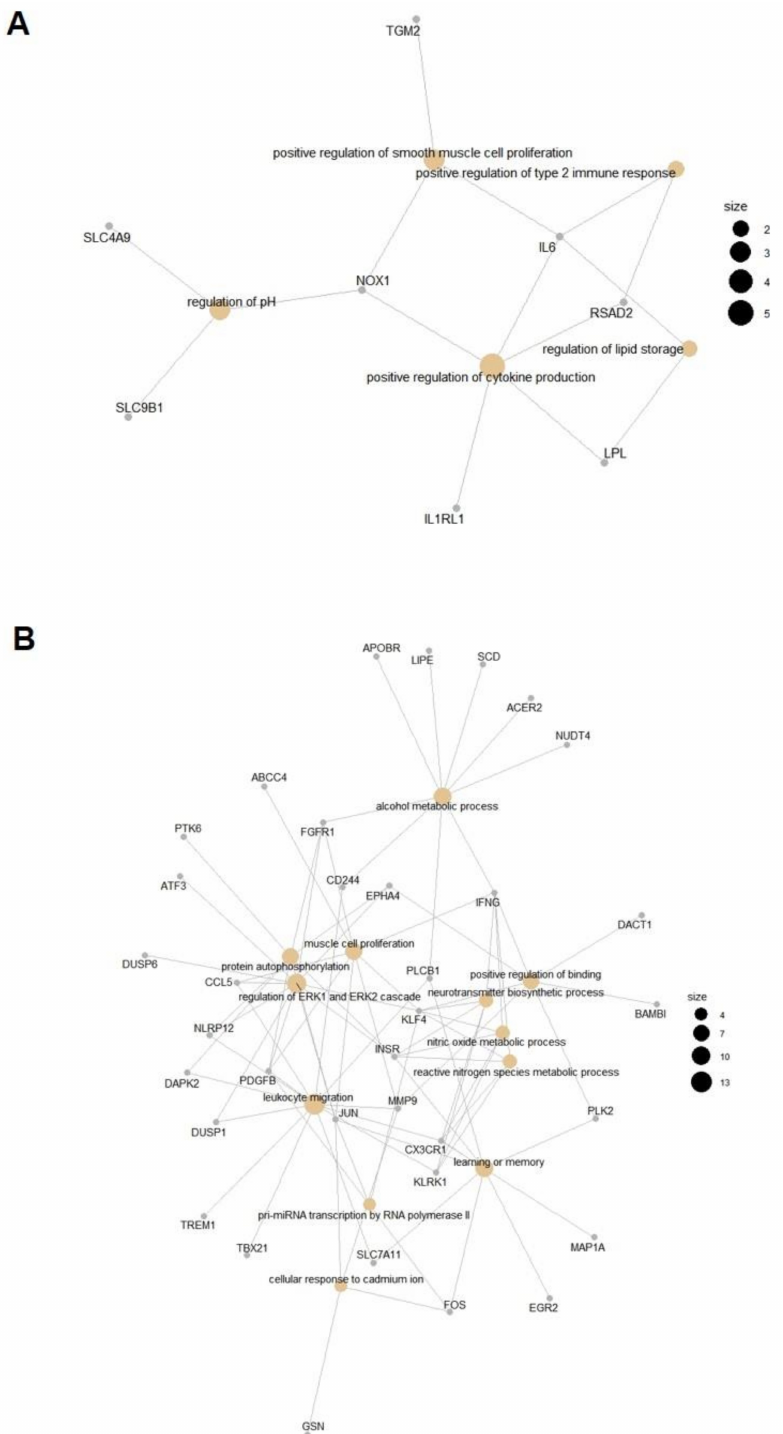
Figure 8. Net plot of the most significantly enriched GO terms and associated genes. ( A ) Upregulated biological process and ( B ) downregulated biological processes. The nonredundant GO terms are listed here with the associated genes from our gene list. Tan nodes represent the GO term and gray nodes represent genes. The size of the GO term nodes indicates the number of genes from our list associated with that term. The biological processes and the associated genes cluster based on